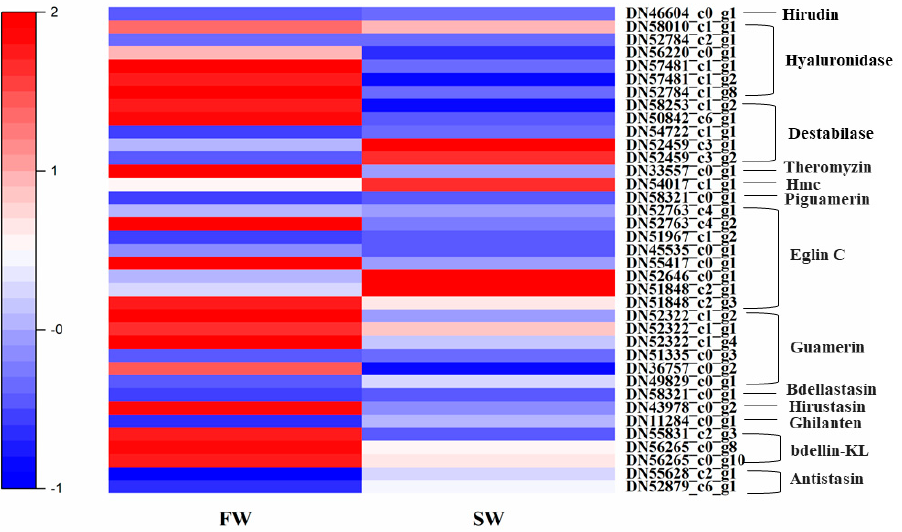
Figure 7. Heat map of gene expression related to anticoagulation and antibacterial activities in FW leeches and SW leeches.